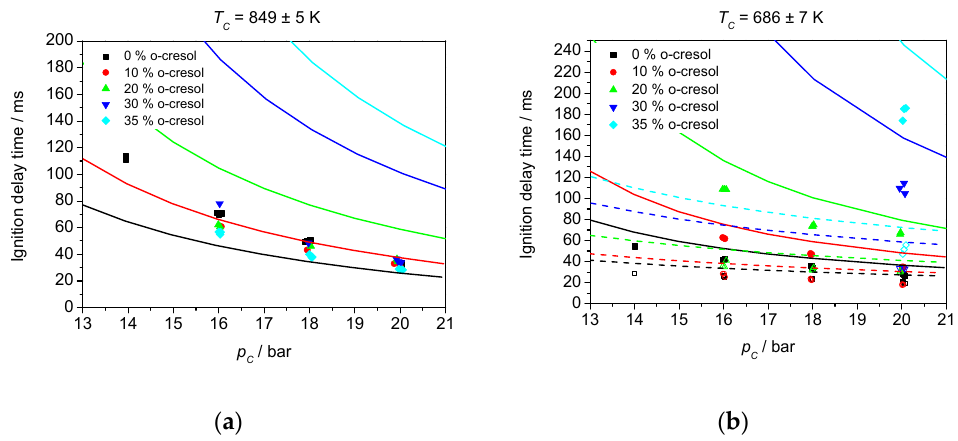
Figure 3. Experimental (symbols) and simulated (lines) effect of the compressed pressure P C on the first-stage (open symbols, dashed lines) and total (full symbols, solid lines) ignition delays of stoichiometric iso -octane/ ortho- cresol mixtures. ( a ) T C = 850 ± 5 K, ( b ) 686 ± 7 K. To gain further insight, an 80/20% mol. iso -octane/ ortho -cresol mixture was further studied. A comparison of the evolution of its IDTs as a function of temperature with a